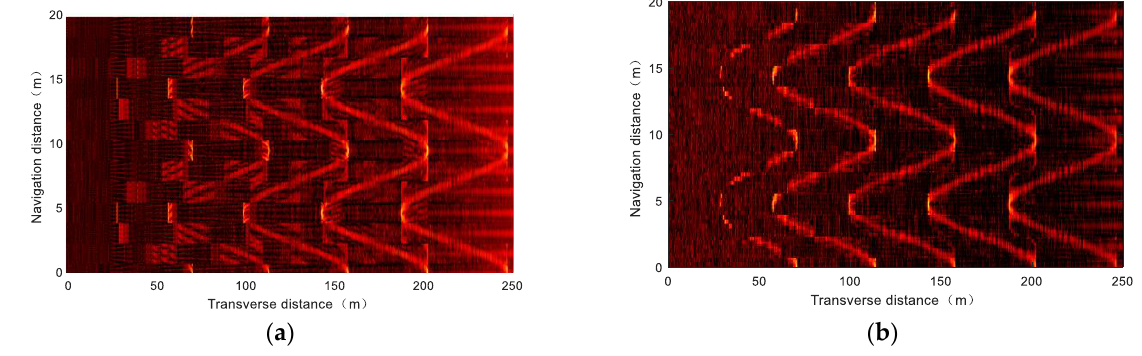
Figure 11. Simulation mapping images at 10knots: ( a ) conventional beamforming; ( b ) dynamic focused beamforming. The receiving sensor consists of 5 subarrays using LFM signal as center frequency 400 kHz, bandwidth 30 kHz, and pulse width 5 ms.